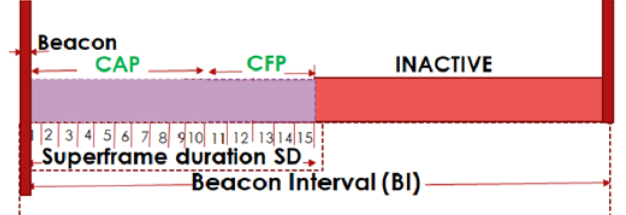
Figure 2. The frame composition.